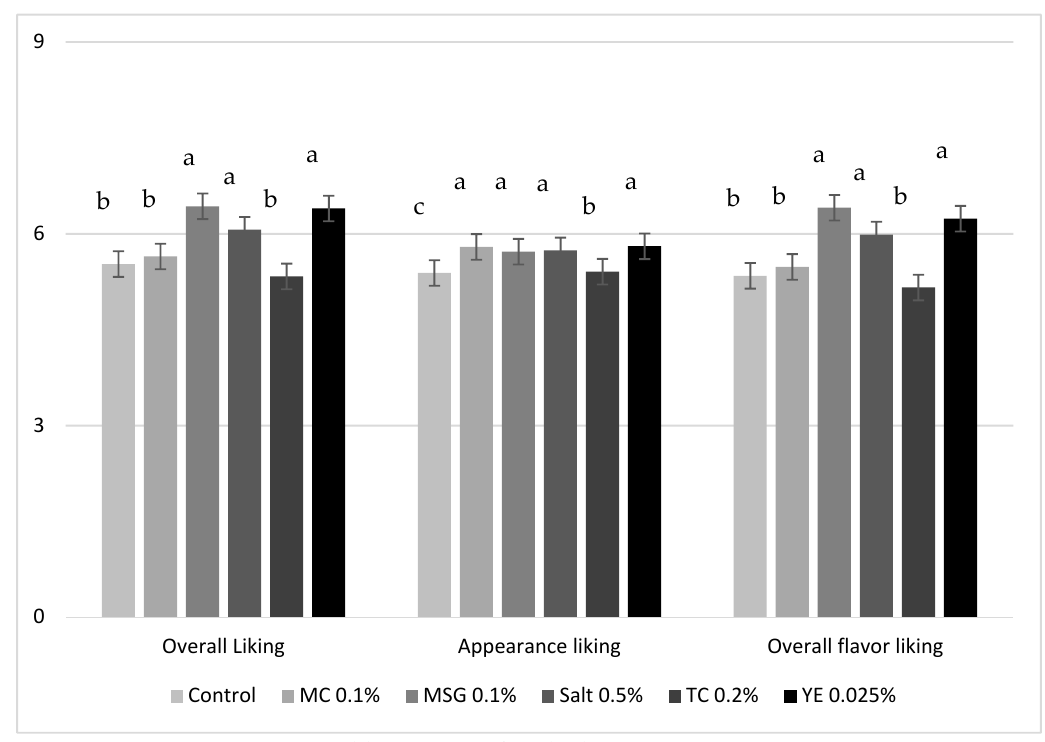
Figure 1. Mean consumer liking scores for chicken soups. MC, mushroom concentrate; MSG, monosodium glutamate; TC, tomato concentrate; YE, yeast extract.